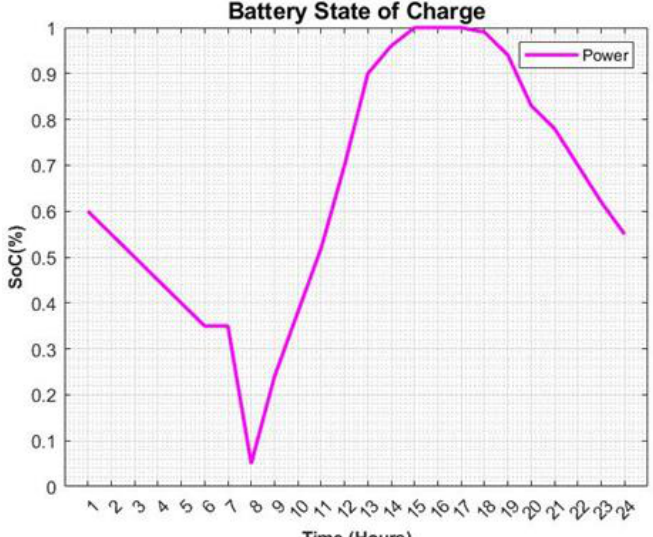
Figure 10. Excess power available after feeding the DS and charging batteries .